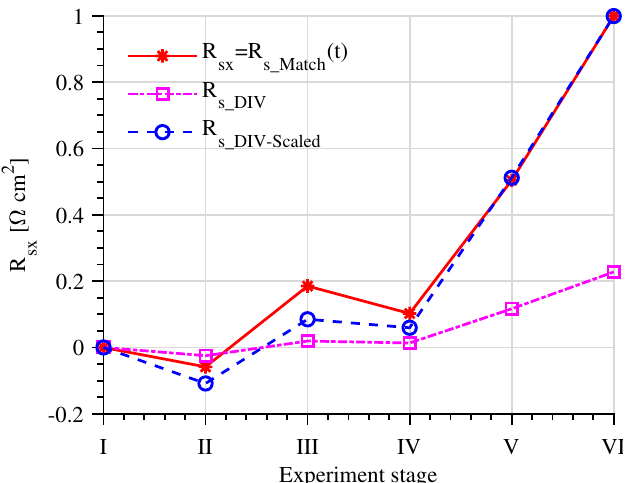
Figure 11. Comparison of the three PV module series resistance procedures, exemplified for PV module #1: R s _ DIV - series resistance estimated from the dark I-V as in (3); R s _ Match - series resistance estimated by matching the final STC P max I-V as in (6) and (7); R s _ DIV by scaling R s _ DIV with the final R s _ Match as in (8).